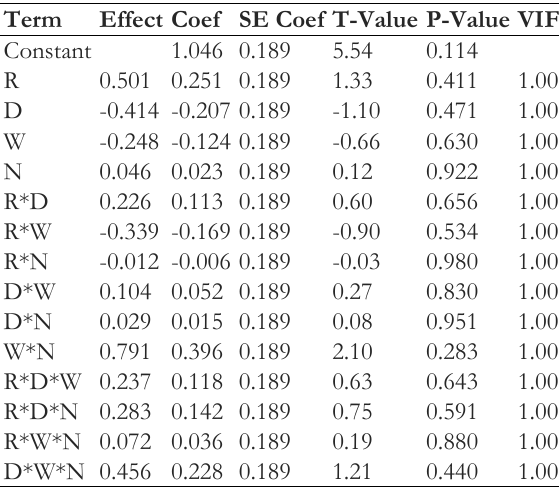
Table 5. Coded coefficient for factorial regression: SD versus R, D, W,